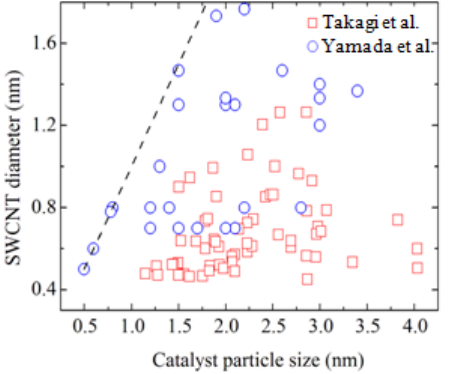
Figure 2. Size correlation between catalyst nanoparticle and SWCNT. Rectangles and circles represent data in Refs. [10] and [18],